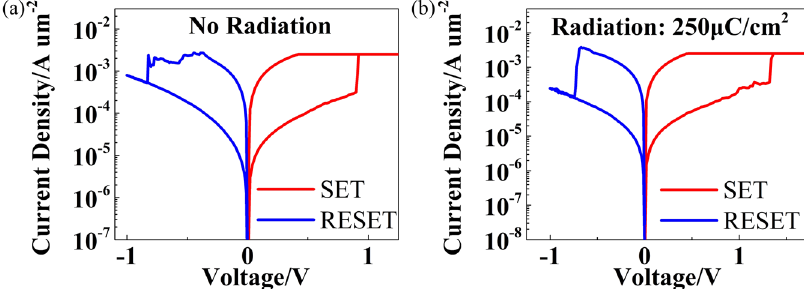
Fig. 6 Representative I – V switching curves of MoS 2 -based NVRS devices. Typical bipolar I – V curves ( y -axis in current density) of resistive switching behavior in ( a ) unirradiated devices and ( b ) devices with e-beam irradiation treatment at dose of 250 μ C/cm 2